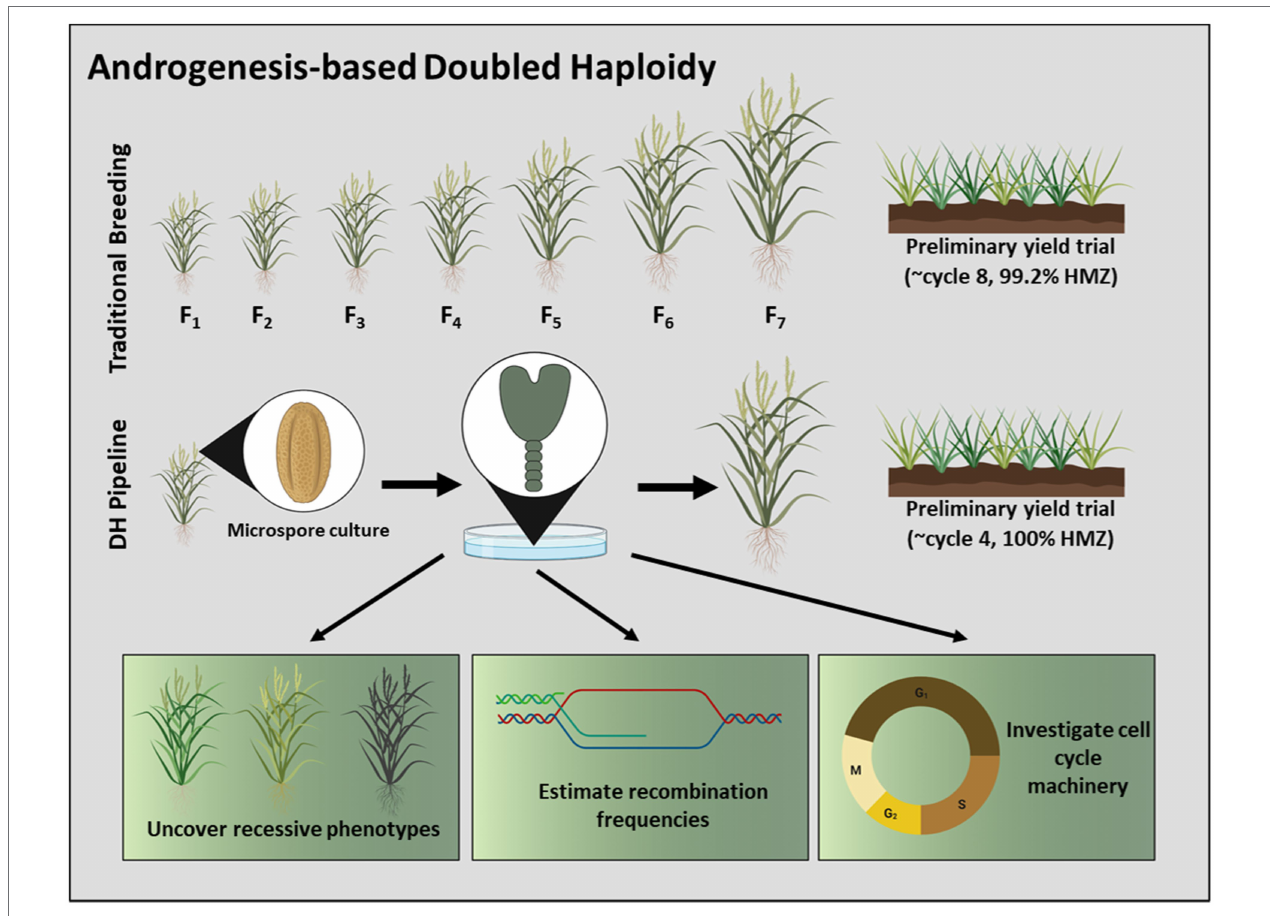
FIGURE 1 | Schematic overview of androgenesis-based doubled haploidy and its uses in plant breeding. A DH pipeline has the capacity to advance cultivar development in a timeframe unmatched by traditional methods. The nature of microspore-derived DH’s permits their exploitation to uncover recessive phenotypes, to estimate recombination frequencies, and to investigate cell cycle machinery, among other benefits. Note that wheat ( Triticum aestivum ) is depictive of all species, and the number of cycles is plant-specific. Moreover, this illustration considers in vitro embryogenesis to be a cycle in the breeding